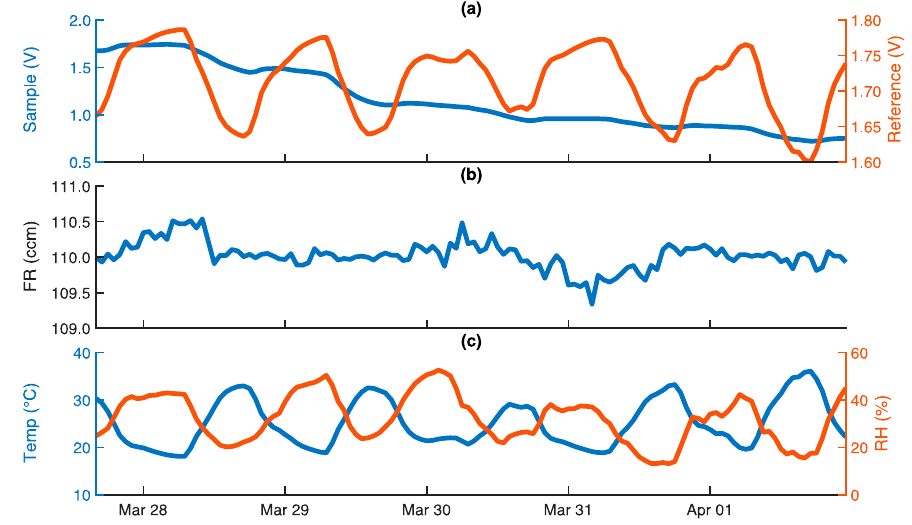
Figure A2. Uncompensated (raw) data measurements collected by an ABCD operating outdoors: ( a )